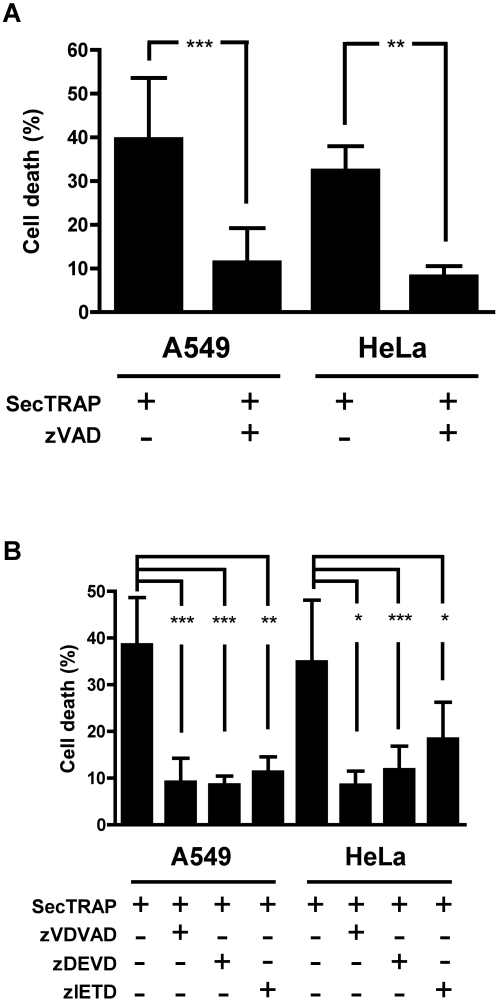
Cell death induction by SecTRAPs is prevented by caspase-2 and caspase-3/7 inhibitors.(A) shows that the cell death provoked by SecTRAPs is significantly decreased upon preincubation of either A549 or HeLa cells for 30 min with 100 µM of the general caspase inhibitor zVAD before the SecTRAP treatment (**, p<0.01; ***, p<0.001). In (B) HeLa or A549 cells were incubated 30 min with 25 µM of inhibitors for caspase-2 (zVDVAD-fmk), caspase-3 (zDEVD-fmk) or caspase-8 (zIETD-fmk) before SecTRAP treatment. In all of these cases a significantly lower cell death was observed, as indicated in the figure, suggesting that the three caspases may be involved in propagating the cell death triggered by SecTRAPs, as further discussed in the text (*, p<0.05; **, p<0.01; ***, p<0.001).